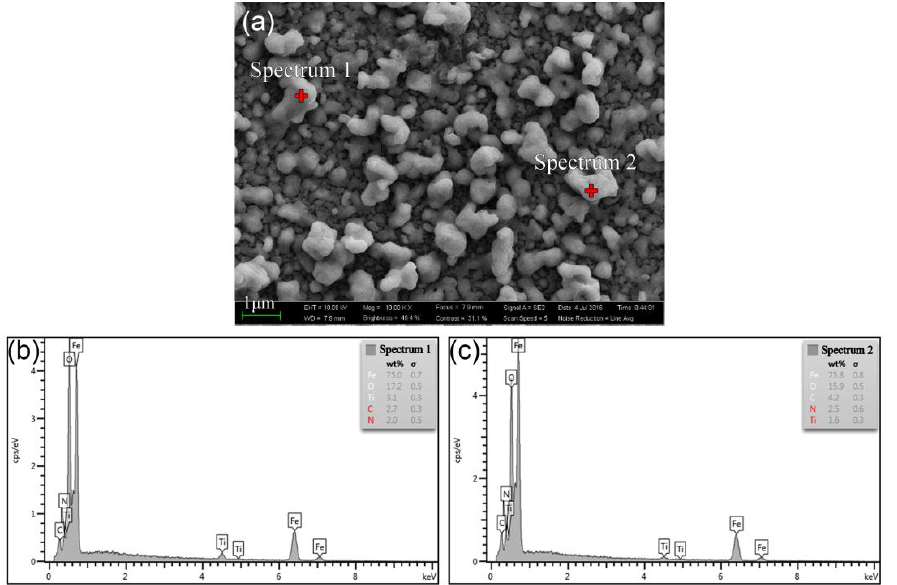
Figure 8. Elemental composition of the white phases by point EDS analysis: ( a ) the picked points for EDS analysis, ( b ) EDS result for point 1, ( c ) EDS result for point 2.